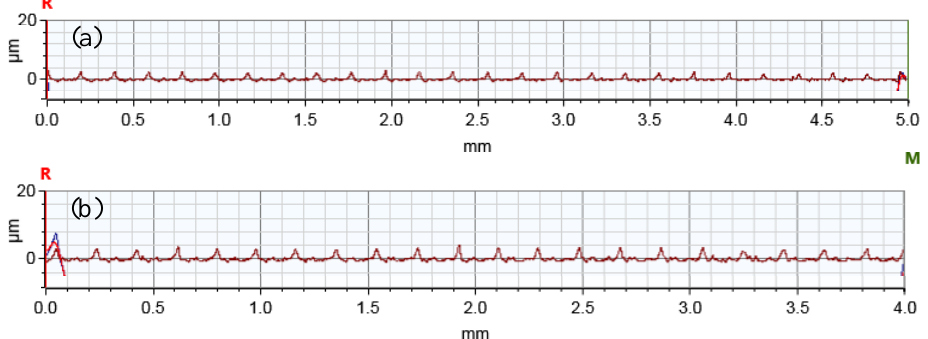
Figure 6. Two-dimensional roughness profiles at V = 30 m/min and f = 0.1 mm/rev for ( a ) AL orientations and ( b ) PL